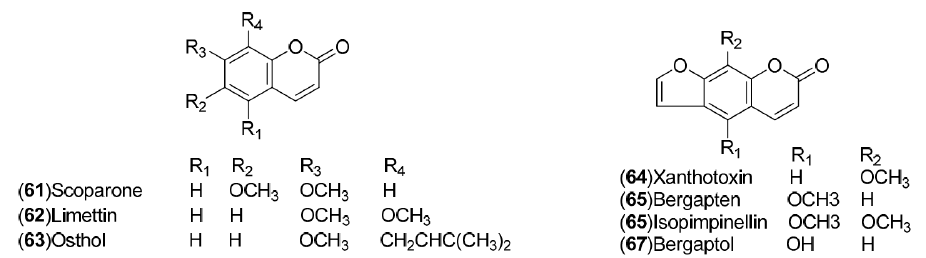
Figure 4. Chemical structures of coumarins.